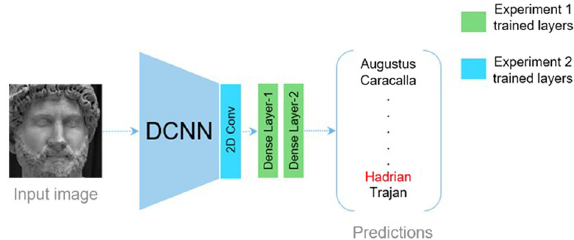
Fig. 6 Schematic overview of experiments. Experiment 1 trains densely connected layers of Inception-Resnet V1 model. Experiment 2 trains last 2D convolutional layer from experiment 1 model. Image of Hadrian: ©